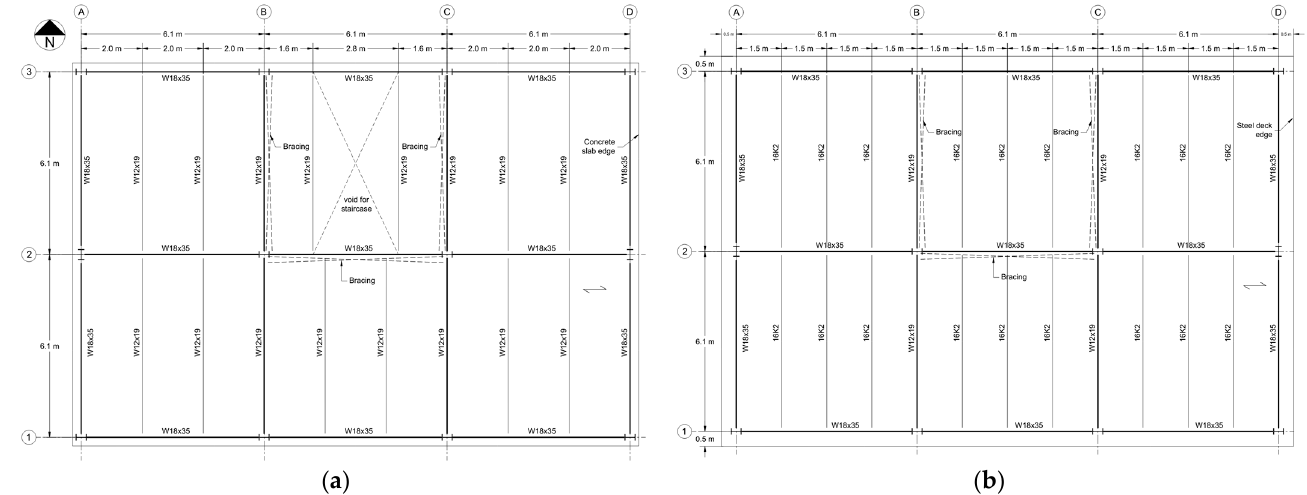
Figure 1. Test structure plan views: ( a ) 2nd and 3rd floor (typical); ( b ) Roof.